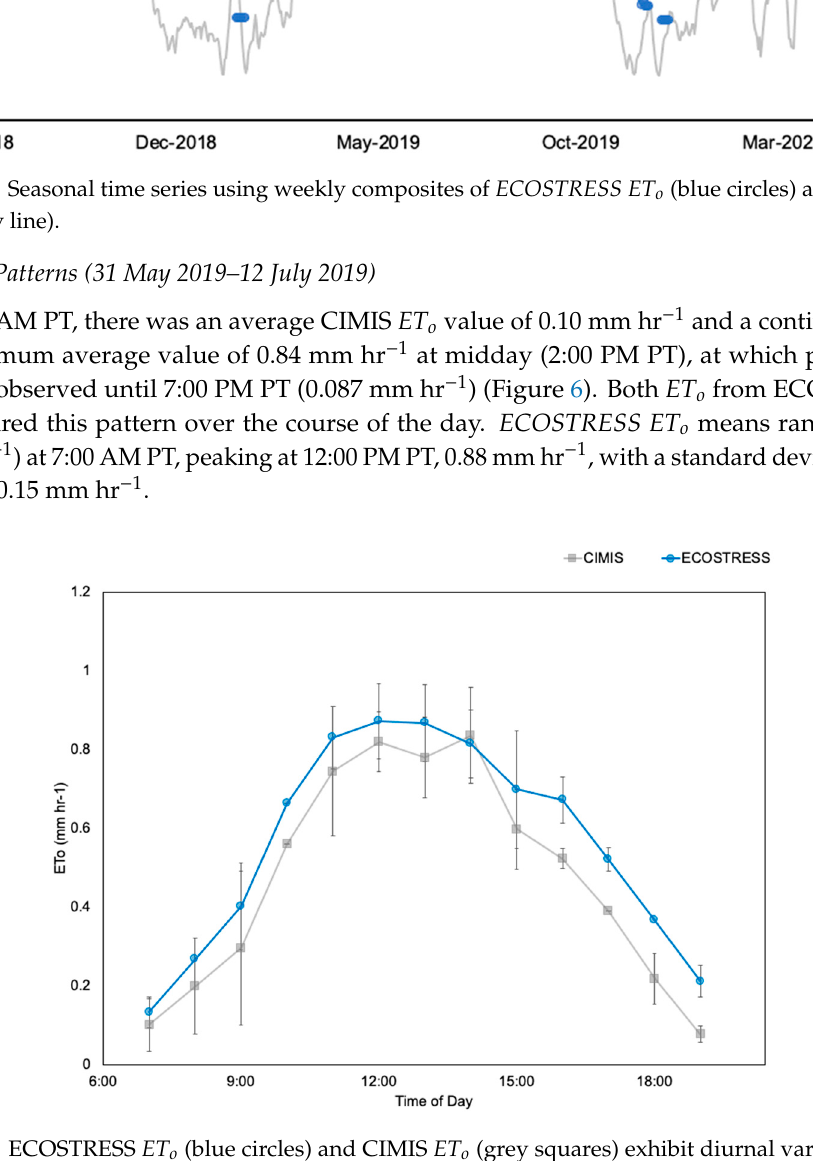
Figure 6. ECOSTRESS ET o (blue circles) and CIMIS ET o (grey squares) exhibit diurnal variability in reference evapotranspiration that peaks during midday hours, with data aggregated for the period of 5/31/2019 to 7/12/2019, over all five stations, and shown over the diurnal cycle. Error bars represent standard deviation of values.